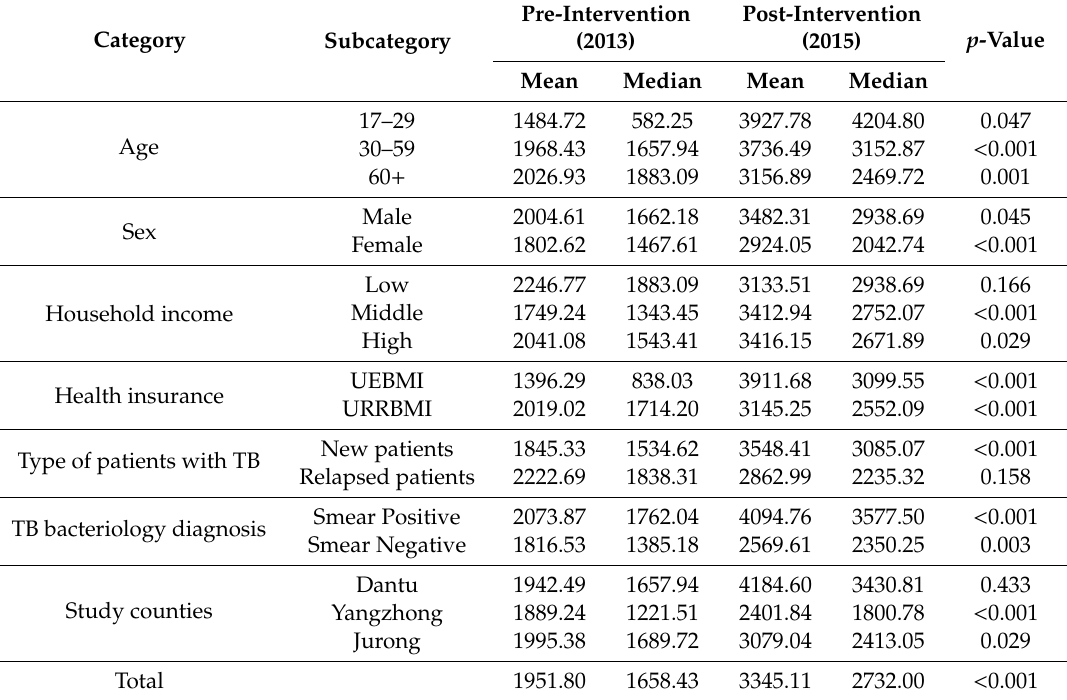
Table 5. MedicalcostsofTBinpatientcareindesignatedhospitalsinZhenjiang, in2013and2015(USdollar*). Category